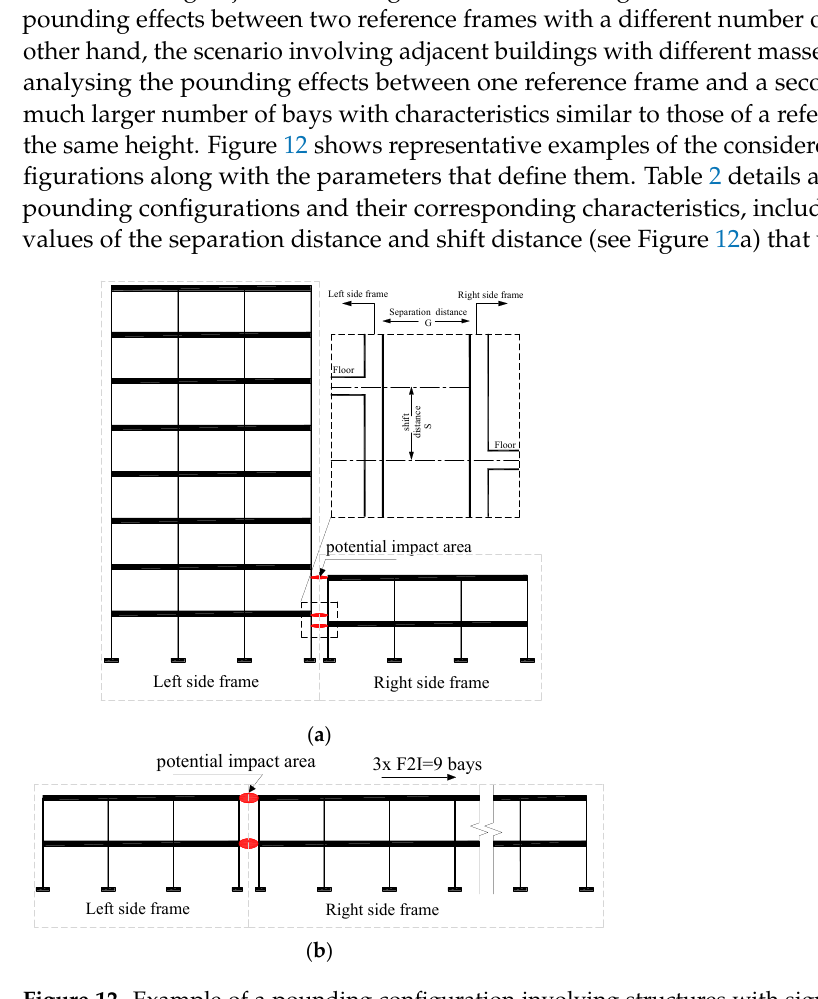
Figure 12. Example of a pounding configuration involving structures with significantly different heights ( a ) and a pounding configuration involving structures with significantly different masses ( b ). ( a ) Pounding configuration involving an 8-storey frame adjacent to a 2-storey frame with floor- to-column contact (F8PS2G0). ( b ) Pounding configuration involving a 2-storey frame adjacent to an extended version (with nine bays) of the 2-storey frame (F2PE2G0) Table 2. Characteristics of the considered adjacent structures representing the different critical pounding configurations ( ■ marks the selected characteristics of a given pounding configuration). Pounding Configurations Adjacent Buildings with Shift Distance Separatio Type of Pounding Left Side Acronym * Significantly No. Right Side Frame n Distance Frame ‡ Different Floor-to- Floor Floor-to- Column Masses Heights 1